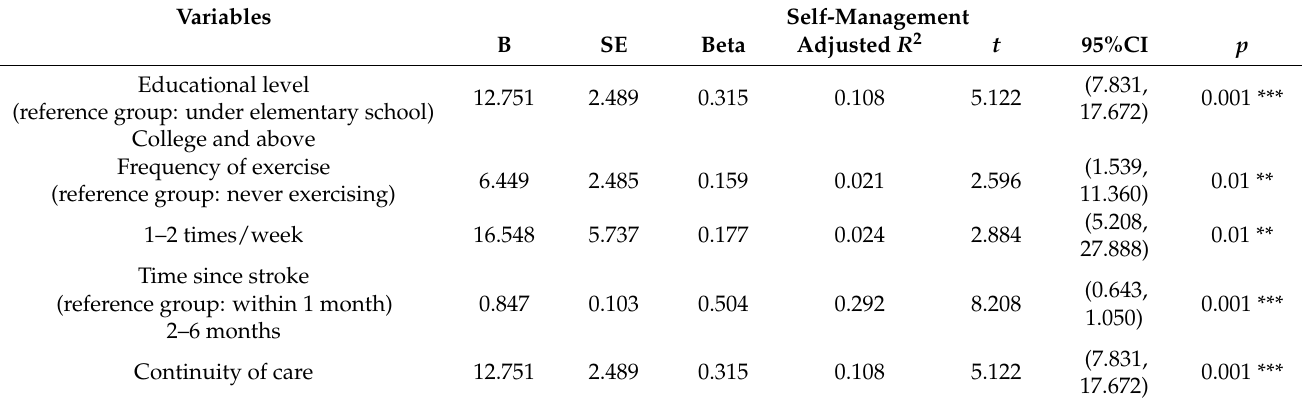
Table 5. Important predictors affecting the self-management of patients with stroke ( N =